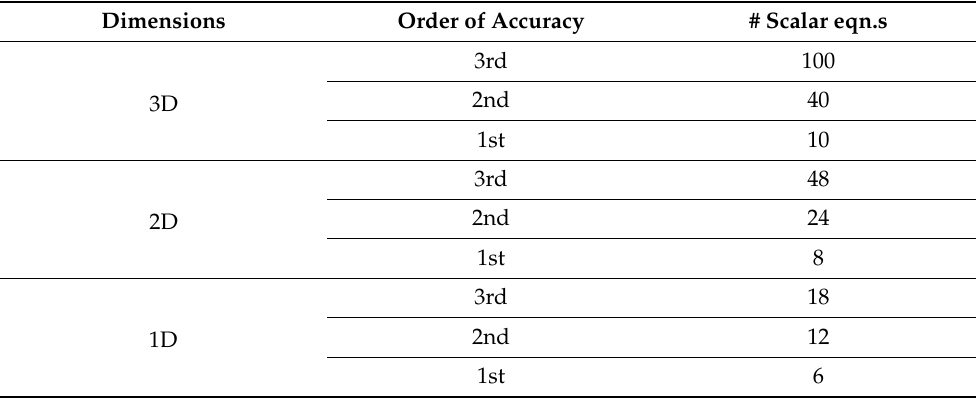
Table 1. Number of scalar equations to be solved.